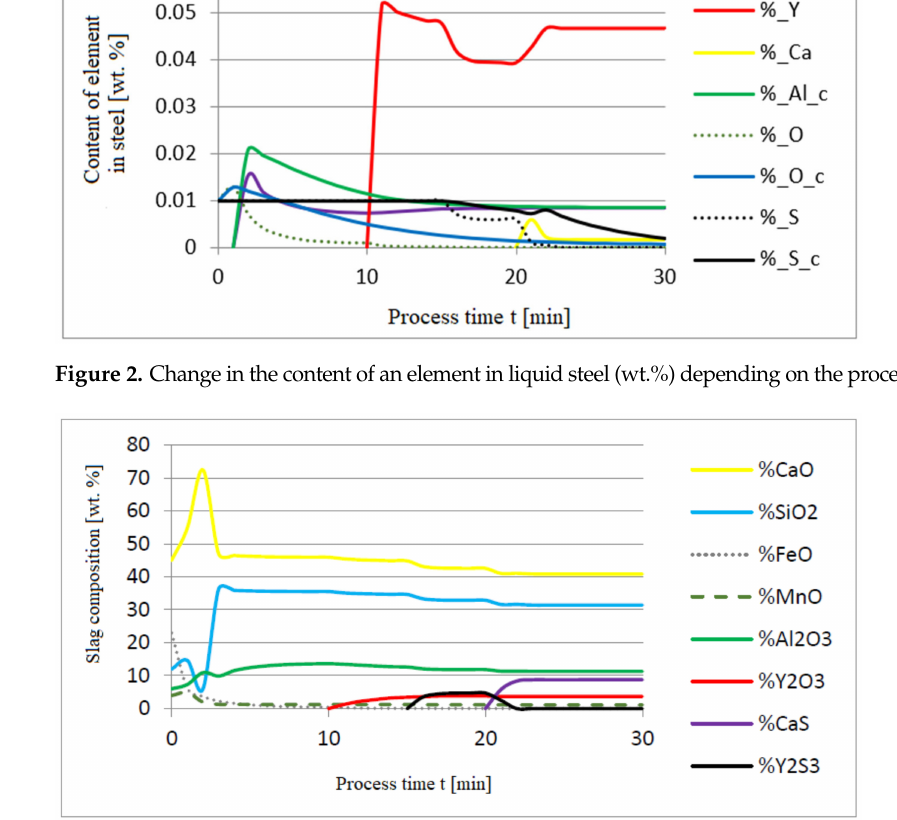
Figure 3. Change in chemical composition of slag (wt.%) depending on the process time t (min).